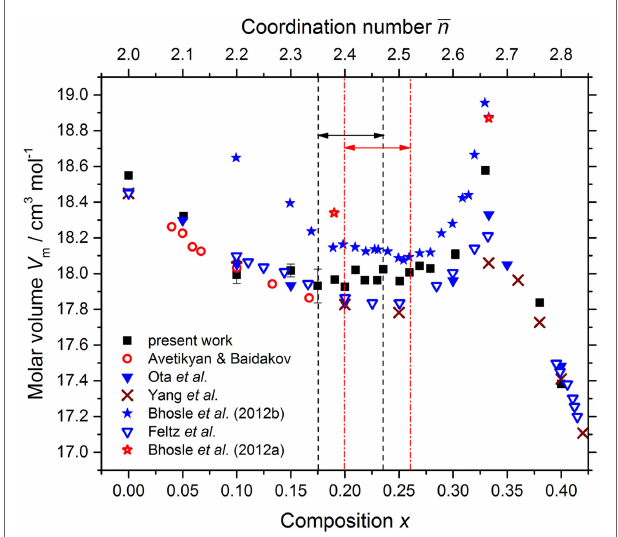
FIGURE 3 | The dependence of the molar volume at room temperature V m for the Ge x Se 1 (cid:0) x system on the composition x and mean coordination number ¯ n = 2 ( 1 + x ) . The results from the present work are compared to those taken from Avetikyan and Baidakov (1972), Bhosle et al. (2012b), Feltz et al. (1983), Ota et al. (1978), and Yang et al. (2013). Data points are also given for the “dry” samples prepared by Bhosle et al. (2012a). The pairs of vertical dashed (black) or chained (red) lines, and associated horizonal arrows, mark compositions for which ∆ H nr ≃ 0 as found in the present work or in the work of Boolchand et al. (2001a),